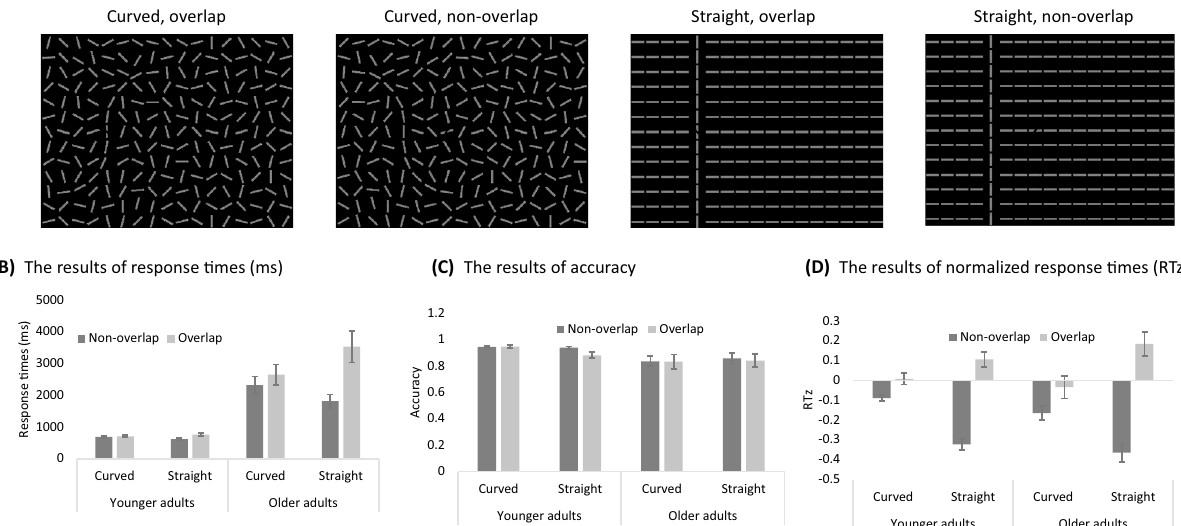
Figure 5. Examples of the search display in the curved and the straight conditions, and the results of younger and older adults in the conditions in experiment 3. ( A ) Examples of the displays used in experiment 3. From left to right are the curved overlap, curved non-overlap, straight overlap, and straight non-overlap conditions. ( B ) The results of response times. ( C ) the results of accuracy, and ( D ) the results of normalized response time (RTz). Error bars are the standard error of the